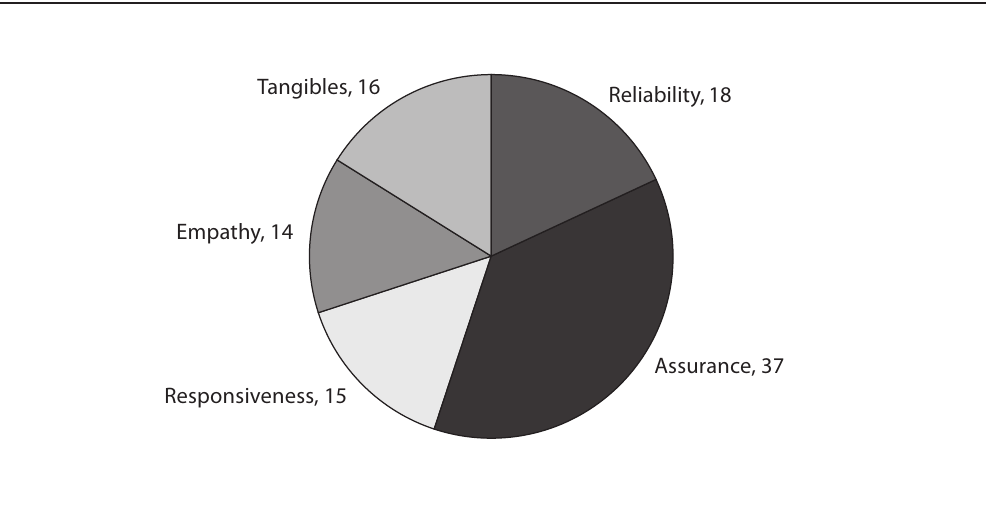
Figure 3 Relative importance of service quality dimensions in the LMS from the learners’